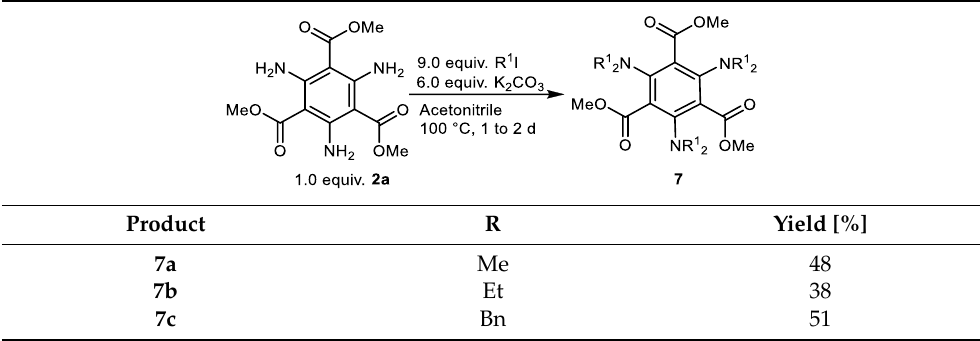
Figure 2. Molecular structures of 2a , 2b and 2c , intramolecular hydrogen bonds drawn at dashed lines, displacement parameters are drawn at 50% probability level (for details, see supporting infor- mation and cif-file). Beside the triamines 2a – c , the structure of 3a was also confirmed by the molecular structure, but due to the poor crystal quality we will not discuss this further ( Figure